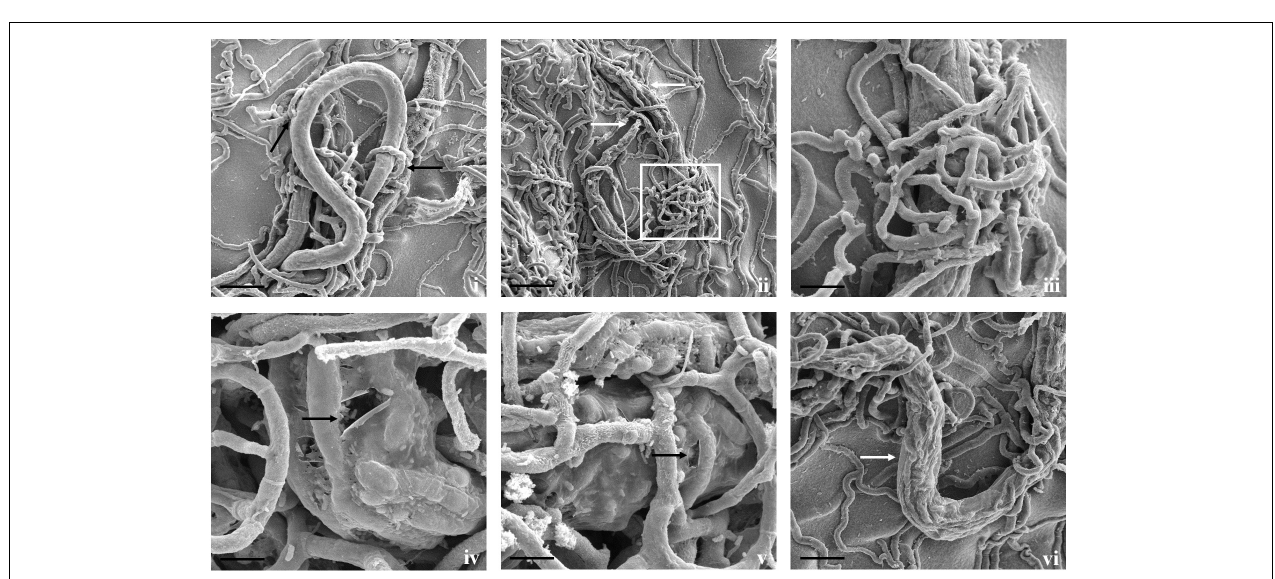
FIGURE 3 | Scanning electron micrographs of interaction between A. thaumasia At_RK and M. incognita . (i,ii) Fungal colonization against many nematodes (white arrows), larvae trapped in fungal networks at various points on nematode body (scale bar = 50, 20 µ m), (iii) magnification of area highlighted (panel ii ) showing pressure caused by modified hyphae on nematode cuticle (scale bar = 5 µ m), (iv) hyphal penetration site (black arrows) on nematodes cuticle along lateral lines (scale bar = 5 µ m), (v,vi) fungus rupturing nematode cuticle (scale bar = 10 µ m), (vii,viii) consumption of nematode body contents by fungus, surface of M. incognita is irregular indicating internal growth of hyphae (scale bar = 5, 10 µ m).